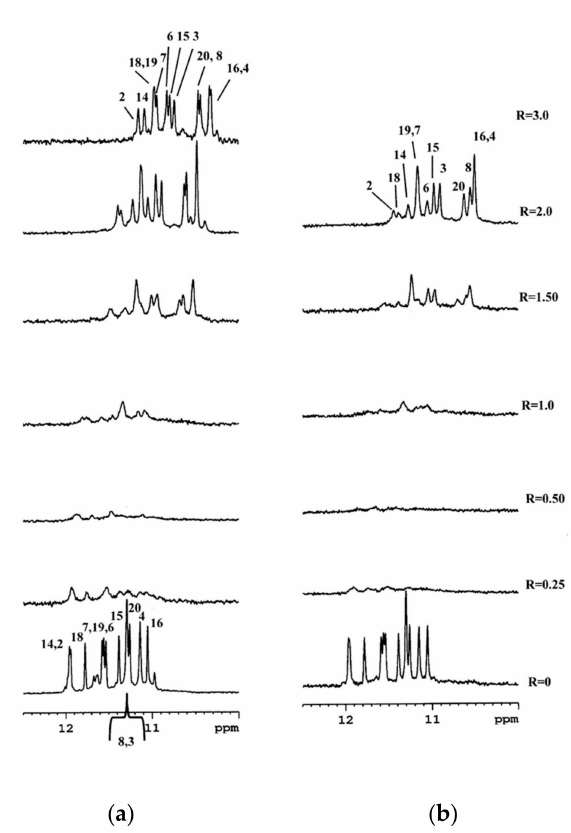
Figure 6. Imino proton region of the 1D NMR titration spectra of c-kit21T12T21 with ( a ) 2 and ( b ) 1 at 25 ◦ C in H 2 O / D 2 0 (9:1), 5 mM KH 2 PO 4 , 20 mM KCl, pH 6.9, at di ff erent R = [drug] / [DNA] ratios. The interaction of both ligands with c-kit21T12T21 induced a large change in the chemical shifts of H1 imino protons: in presence of BA-41 at R = 3.0, ∆ δ ≥ 0.80 ppm for the imino protons belonging to outer G-tetrads and ∆ δ ≤ 0.60 ppm for the internal tetrad. The same trend was observed for the complex with BMH-21 (Table S3, Table S4, Graph S1 and Graph S2). The shift variation of the guanine imino protons of the external G tetrads is the first evidence of the location of the ligand. On the other hand, the upfield shift also observed for the imino protons belonging to the internal tetrad is di ffi cult to explain, but this can suggest an external interaction at the level of this tetrad. None of the NOE cross peaks between the imino protons of the stacked guanine residues in the quadruplex structure disappeared after the addition of the ligands, clearly confirming that the ligands do not intercalate into the